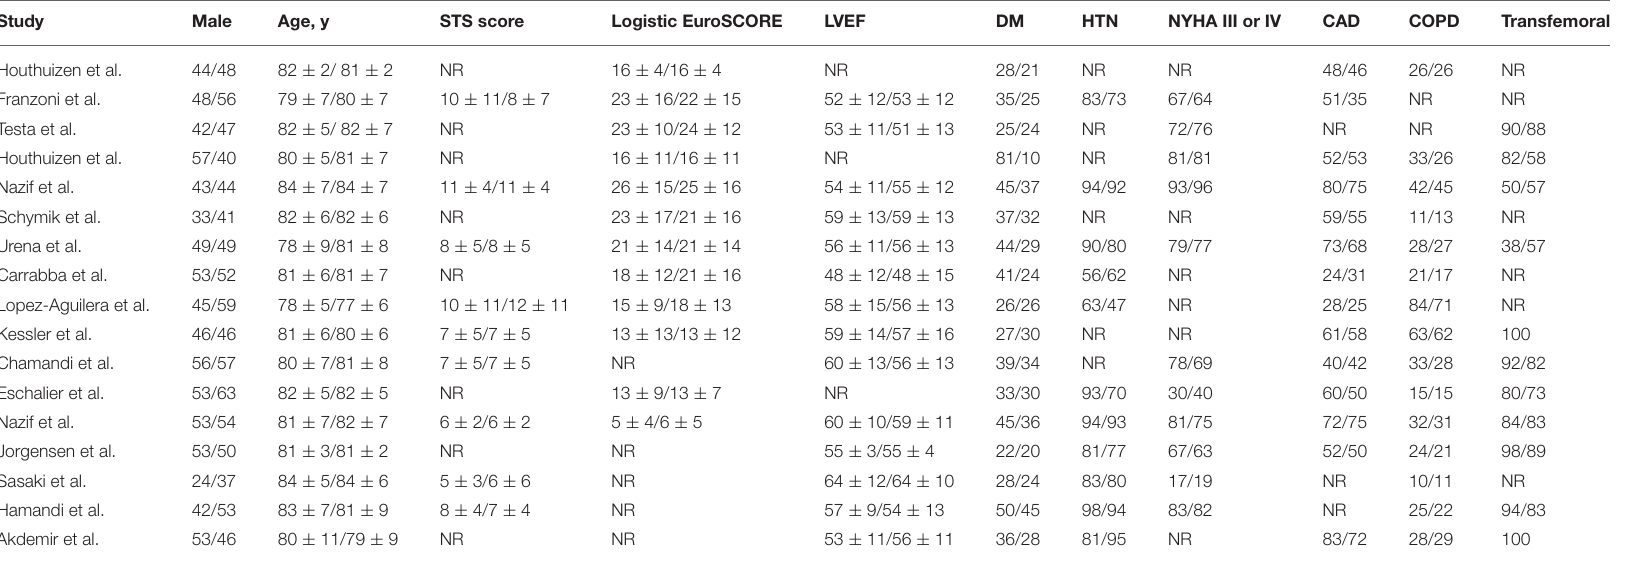
TABLE 2 | Patient and procedural characteristics of included